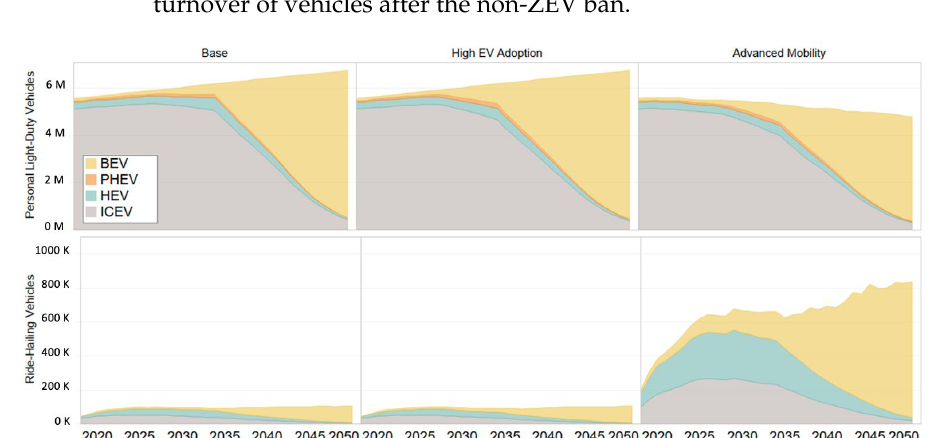
Figure 3. Light-duty vehicle fleet evolution in the San Francisco Bay Area.